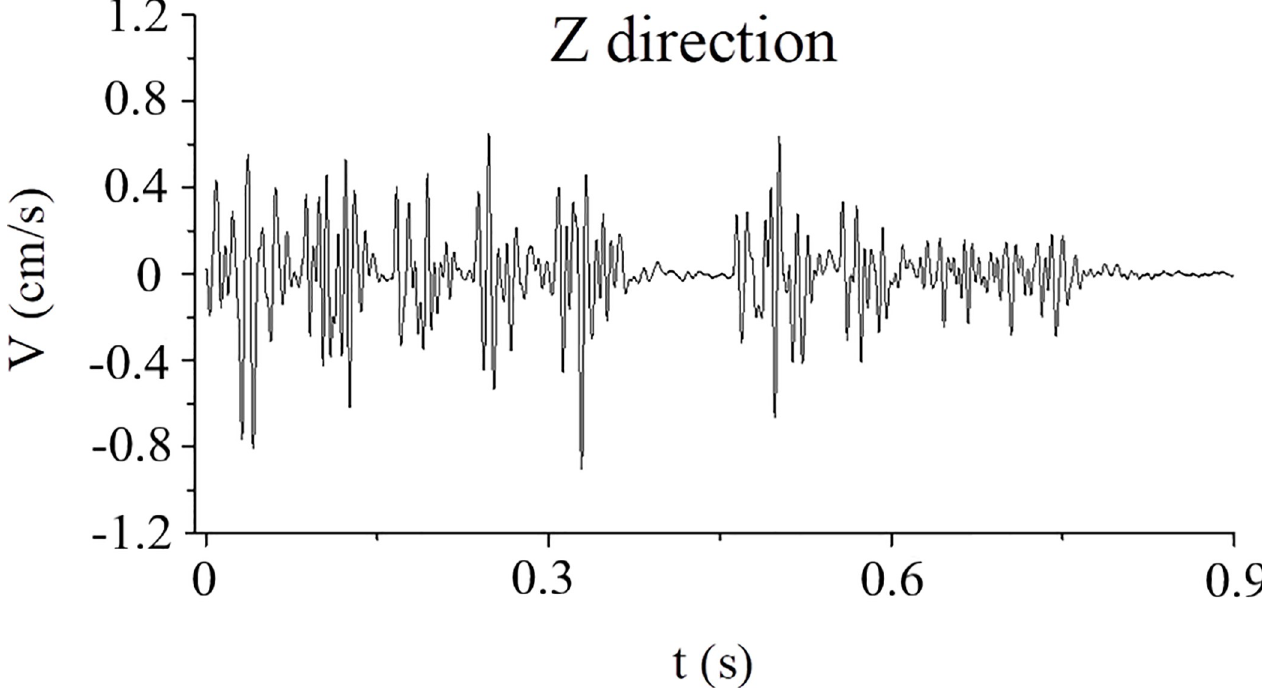
Fig 19. Typical blasting seismic wave using digital electrical detonators.